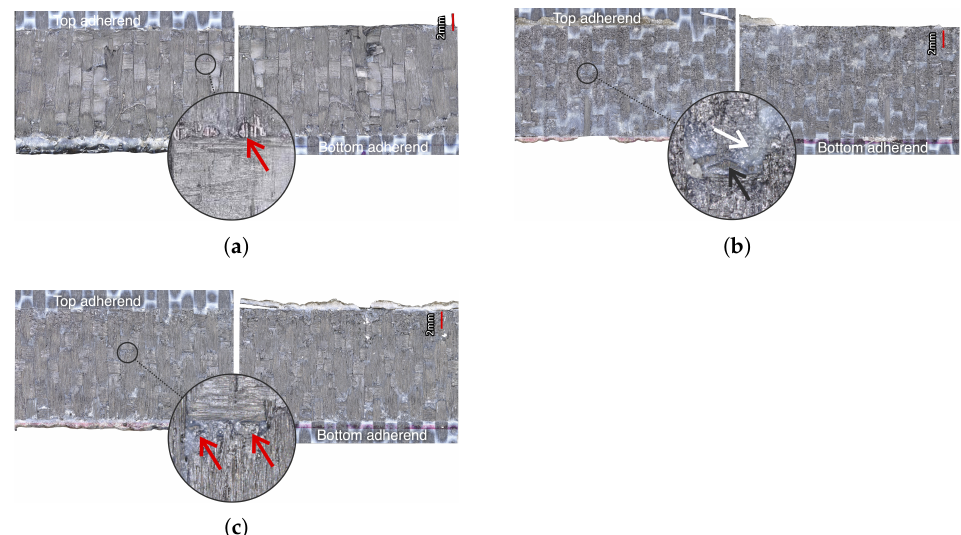
Figure 12. Representative fracture surfaces from continuous welds for ( a ) the reference case, ( b ) higher welding speed case (65 mm/s), and ( c ) the lower amplitude case. Red arrows indicate voids, white ar- row indicates unwelded area together with voids, and black arrow indicates area without connection between top and bottom adherends. Table 3. Average Lap Shear Strength (LSS) Values with Standard Deviation for Different Continuous and Static Welds. Parameters Process Remarks Reference case. Samples tested from configuration B with consolidation unit (Figure 3b). Lower amplitude case. Samples tested from configuration B with consolidation unit (Figure 3b). Higher speed case. Samples tested from configuration B with consolidation unit (Figure